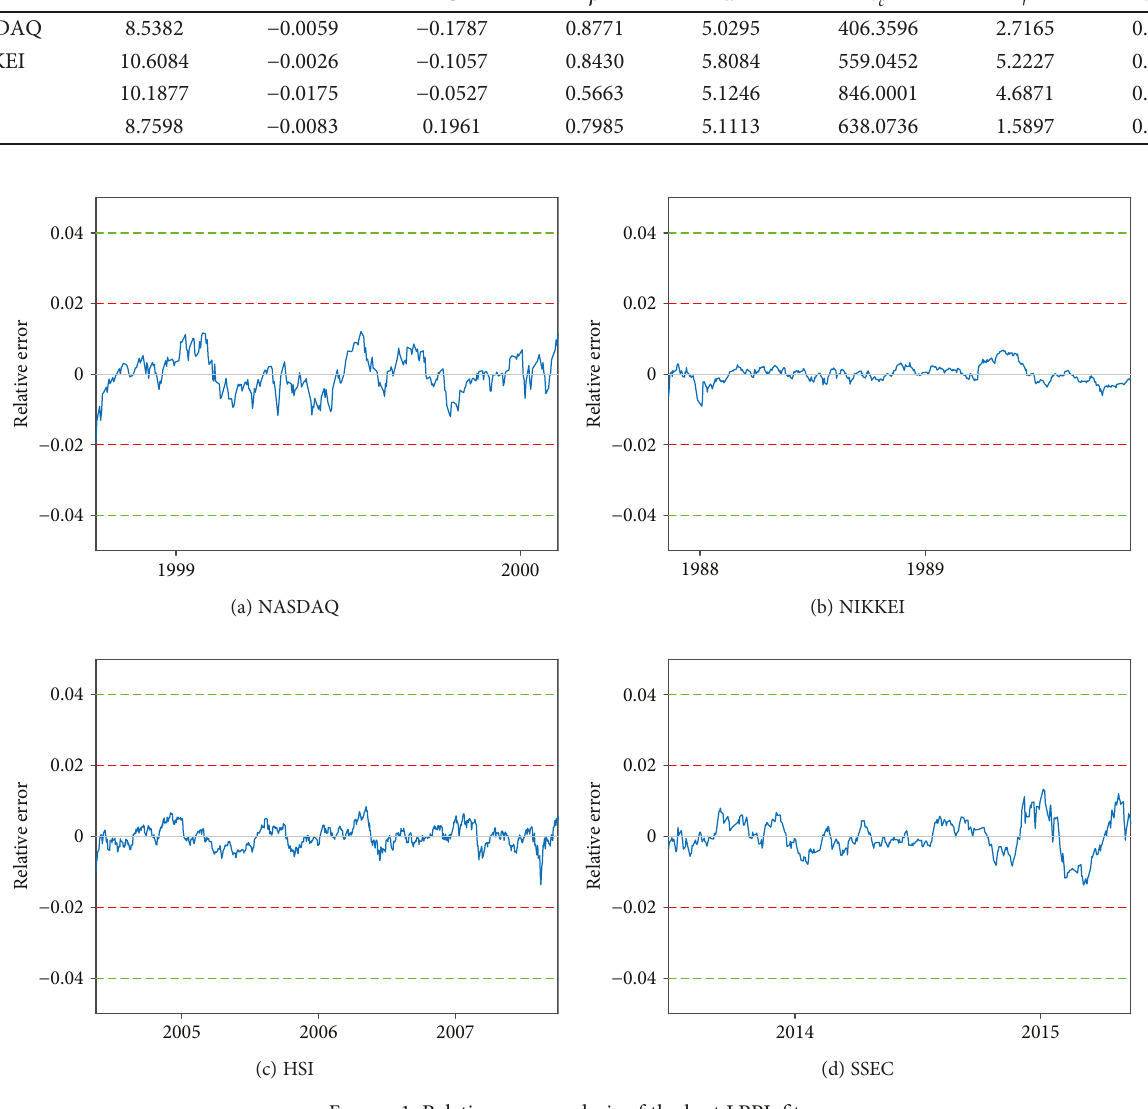
Figure 1: Relative error analysis of the best LPPL fi ts.